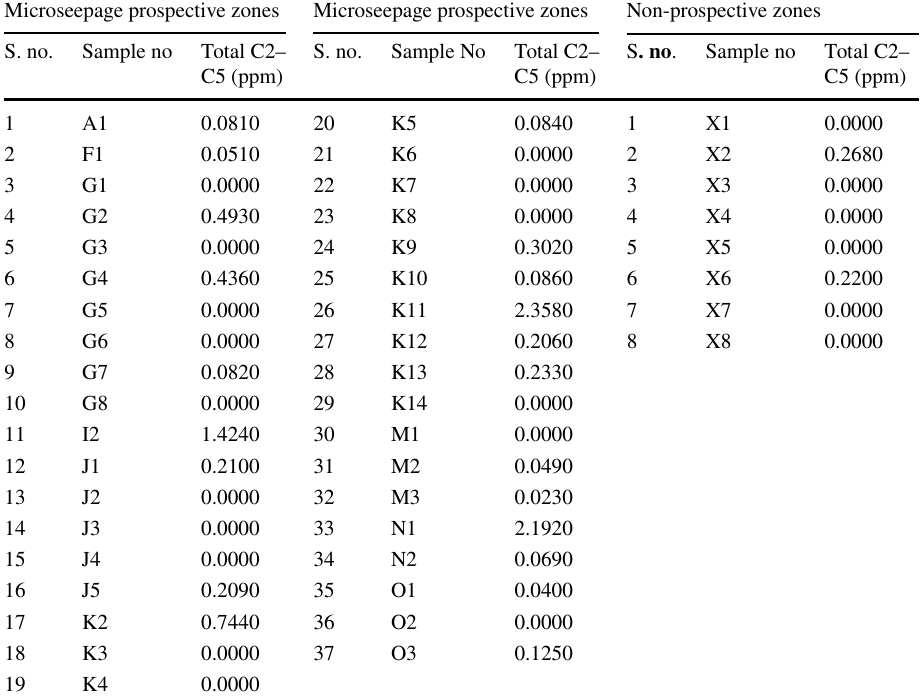
Table 4 Adsorbed gas analysis of samples from hydrocarbon microseepage prospect and non- prospect